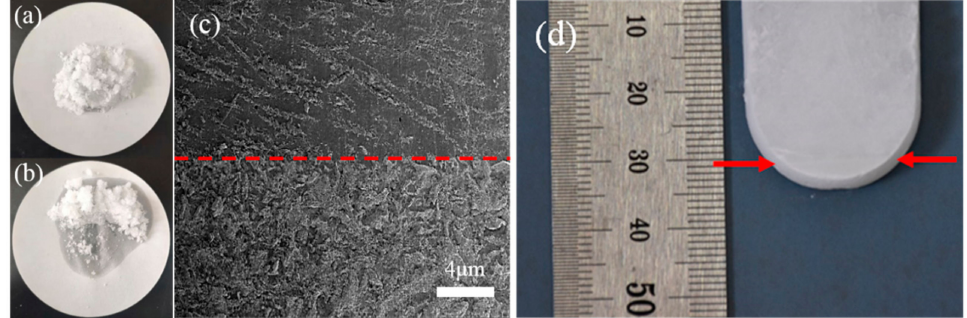
Figure 4. ( a ) The original sample of SAT / 5wt%DSP and ( b ) the sample cycled 200 times; ( c ) SEM image of lower sample of SAT / 5wt%DSP; ( d ) the profile of SAT / 5wt%DSP.